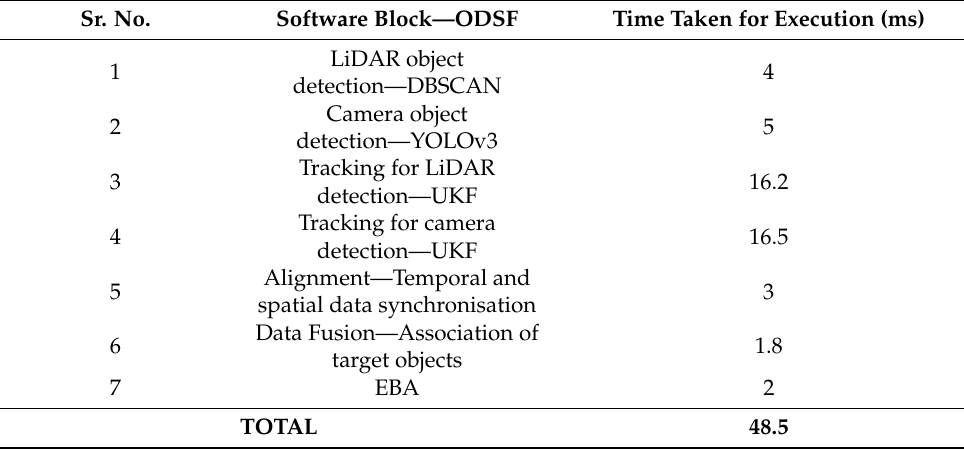
Table 7. Time profiling for EBA driven with ODSF.